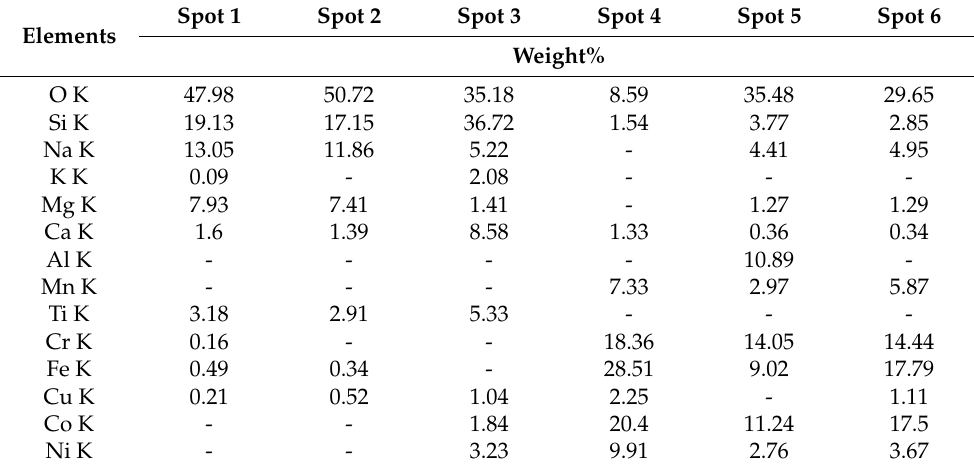
Table 2. Chemical analysis of frit in different points of Figure